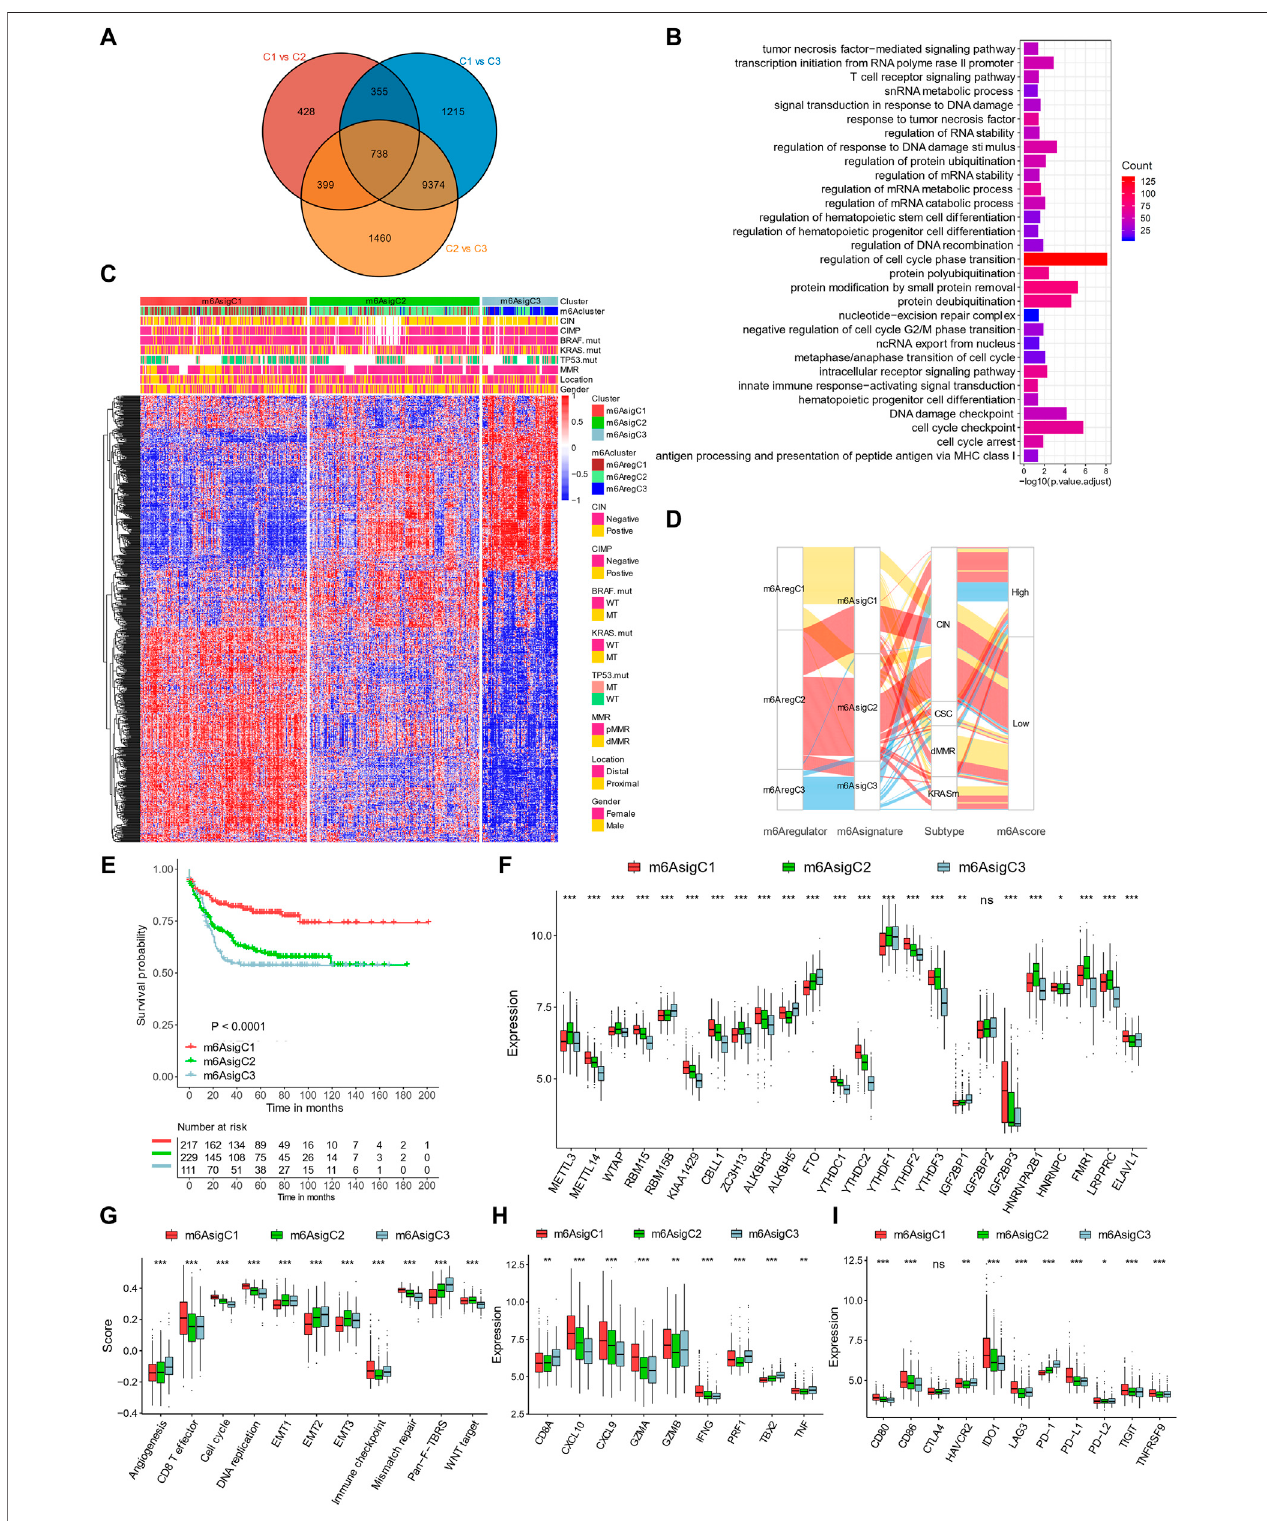
FIGURE4| Constructionofm 6 Asignature – basedclusters. (A) Overlapsofdifferentialexpressiongenesamongthethreem 6 Aregulator – basedsubtypes. (B) Gene Ontology enrichment of the m 6 A signature genes. (C) Clustering patients based on m 6 A signature genes into three subtypes termed m 6 A sig C1 – 3. (D) Alluvial diagram connecting m 6 A reg Clusters, m 6 A sig Clusters, gene mutation subtypes, and m 6 Ascores. (E) Kaplan – Meier curves of the three m 6 A signature – based subtypes. (F) Expression levels of m 6 A regulators in three m 6 A signature – based subtypes. (G – I) Signatures of stromal activation (G) , immune activation (H) , and immune checkpoints (I) in three m 6 A signature – based subtypes. * p < 0.05; ** p < 0.01; *** p < 0.001.